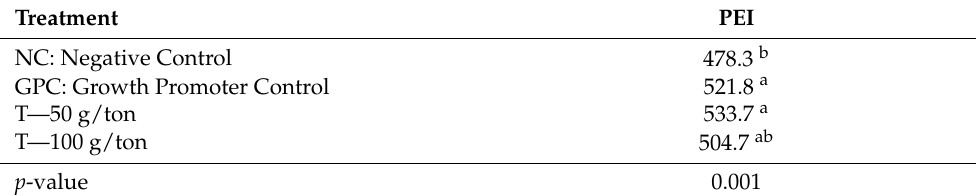
Table 3. Production efficiency index values of broilers fed an antimicrobial blend to replace growth promoters.